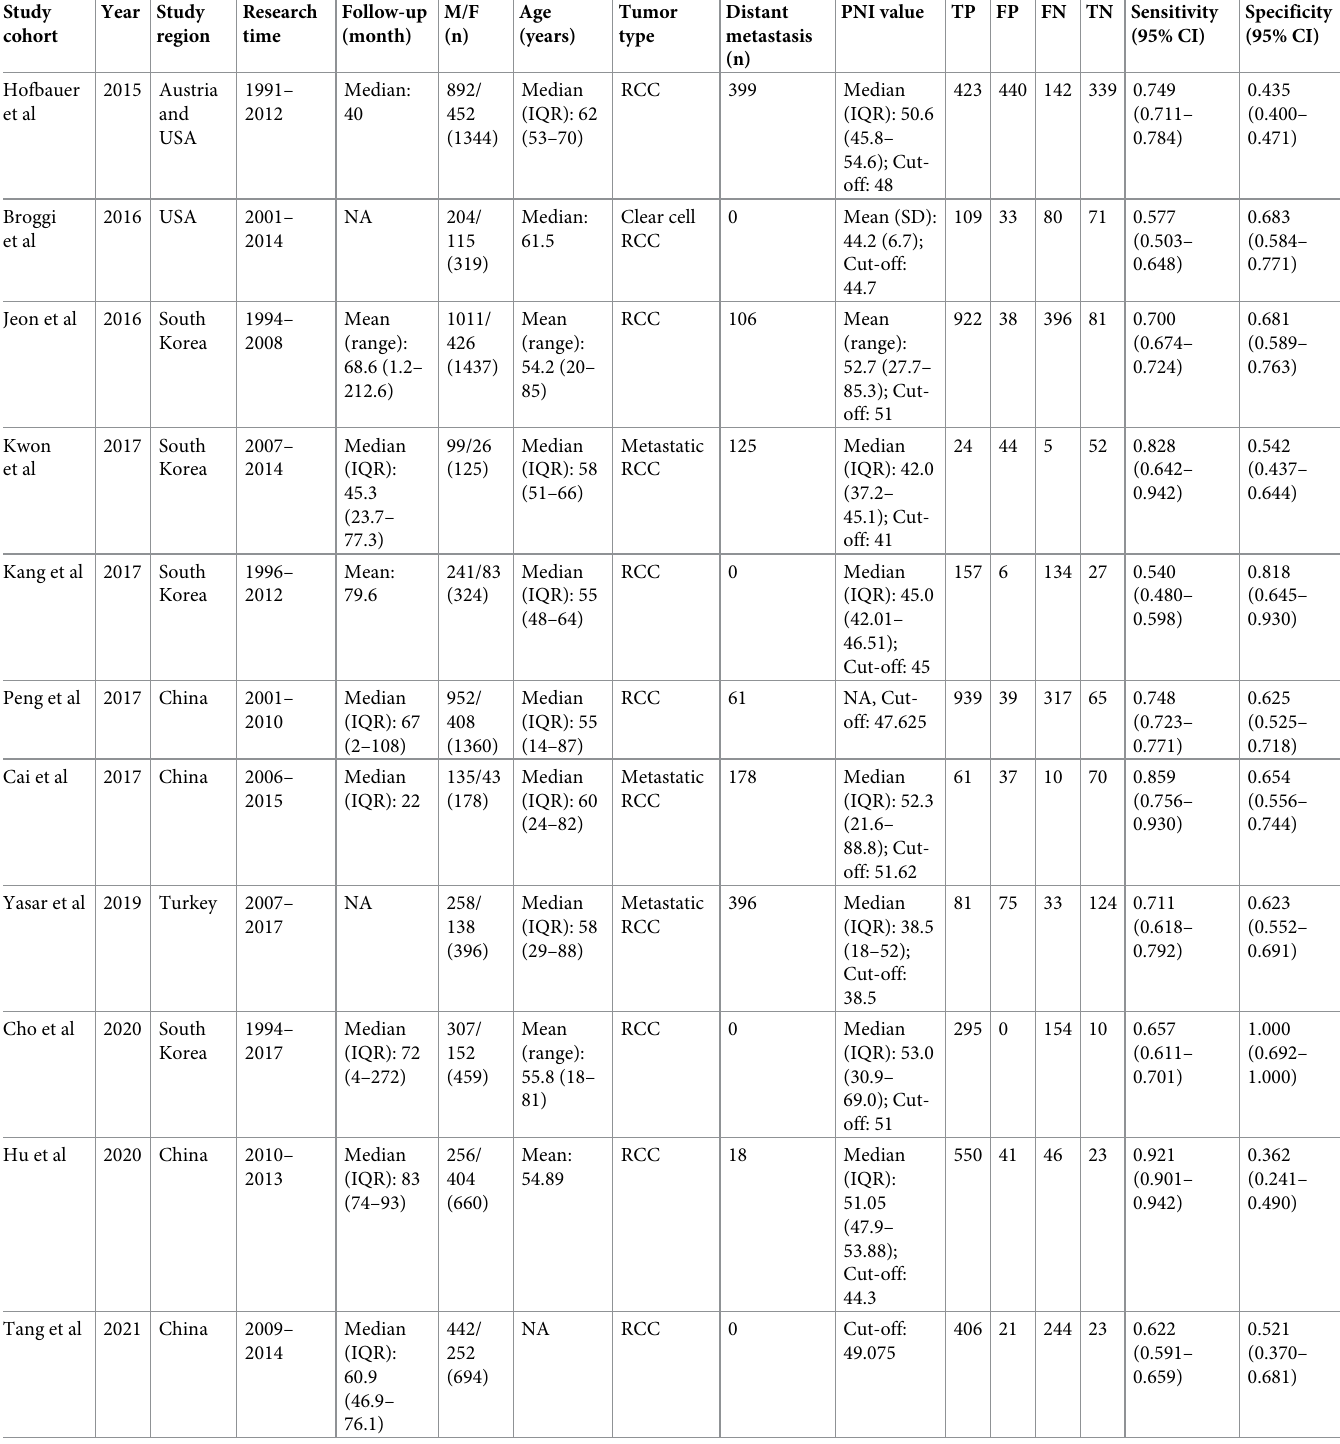
Table 1. Characteristics of all included